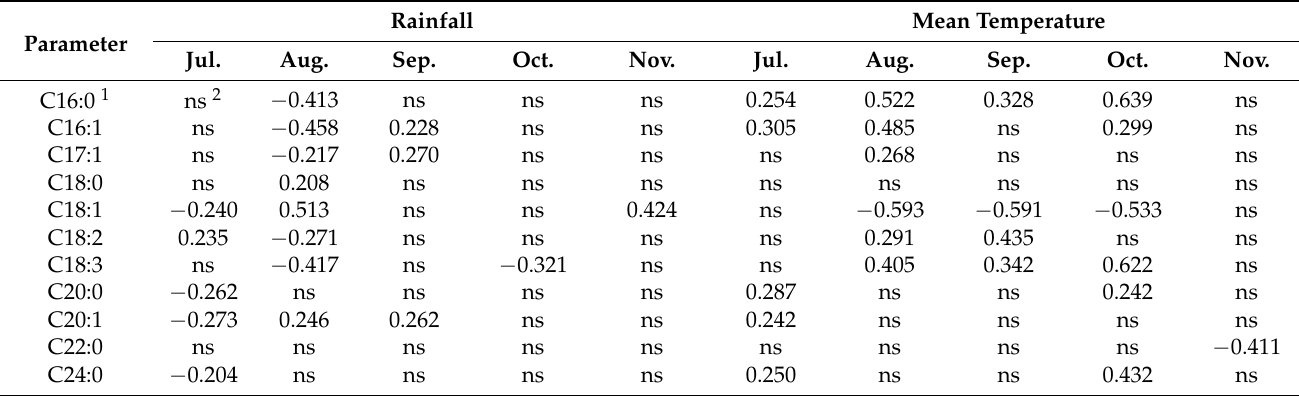
Table 5. Correlation factors of virgin olive oil fatty acid composition and microclimate parameters (rainfall and mean temperature; Figure 1) in the period of olive fruits intensive growth and